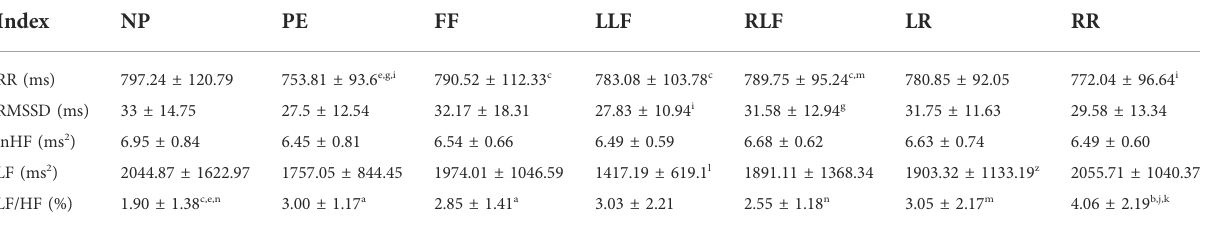
Data are expressed as mean ± SD. NP, neutral position; PE, posterior extension; FF, forward fl exion; LLF, left lateral fl exion; RLF, right lateral fl exion; LR, left rotation; RR, right rotation Note: Between poses with statistical signi fi cance in Tables 2, 3: a p < 0.05 current posture vs. neutral position of the trunk posture b p < 0.01 current posture vs. neutral position of the trunk